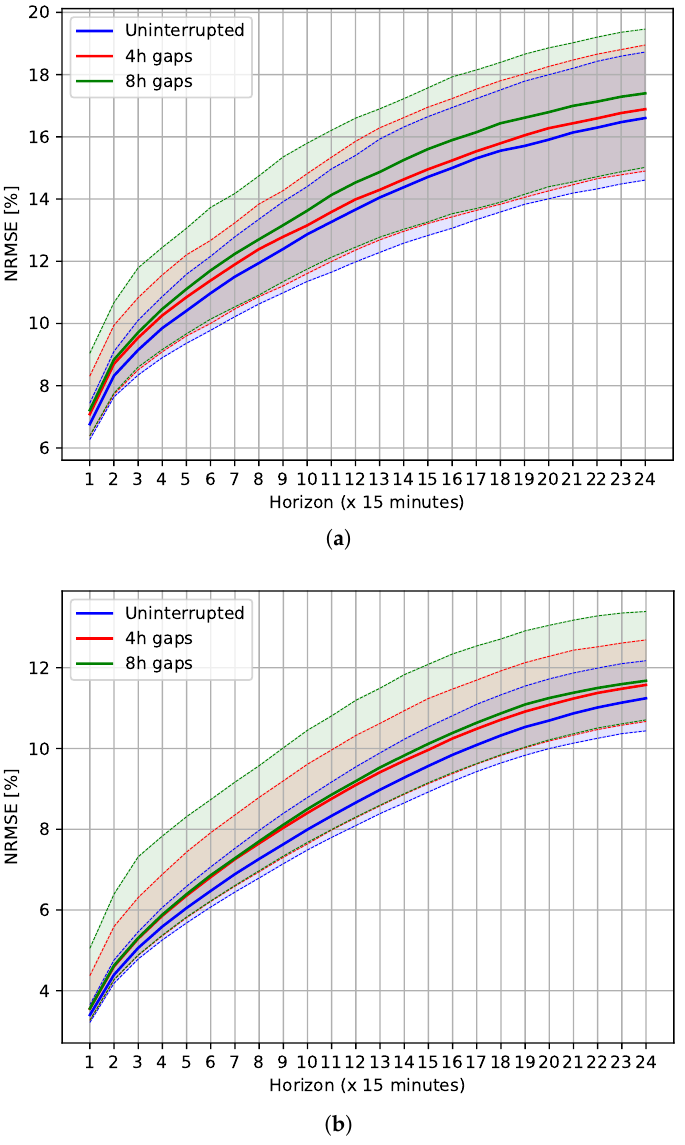
Figure 11. Forecast error comparison between ST-AR with uninterrupted data and ST-AR with data with gaps. ( a ) Forecast NRMSE for the real dataset. ( b ) Forecast NRMSE for the synthetic dataset. The forecast horizon is six hours in steps of 15 min. Solid lines show the median error while the shaded areas show the inter-quantile distance of the